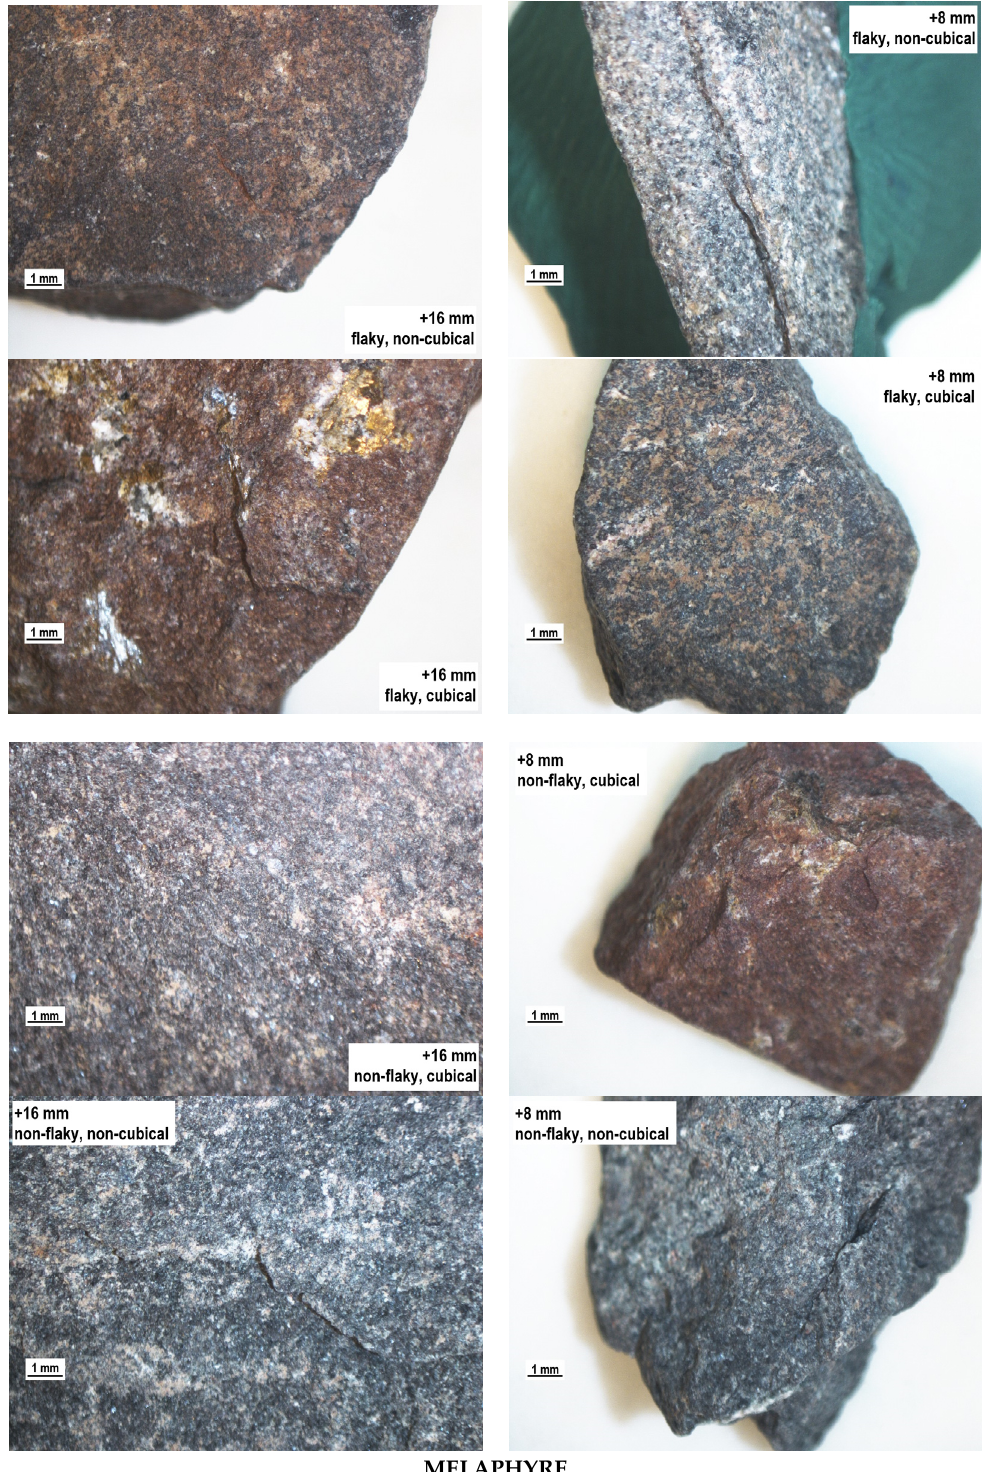
Figure 10. The structure of the particles of the melaphyre aggregate, separate for the shape and particle size.